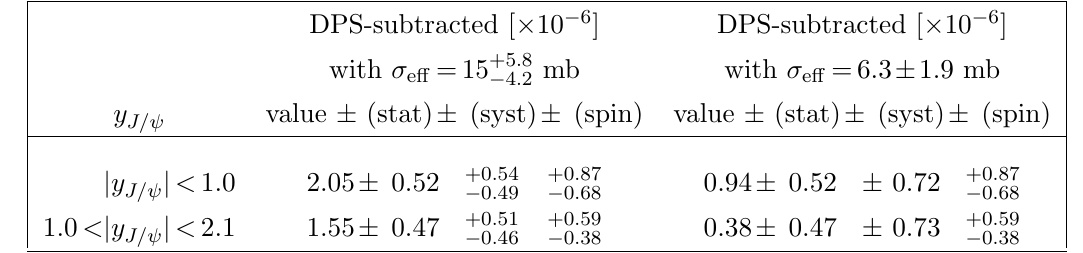
for two di(cid:11)erent J=